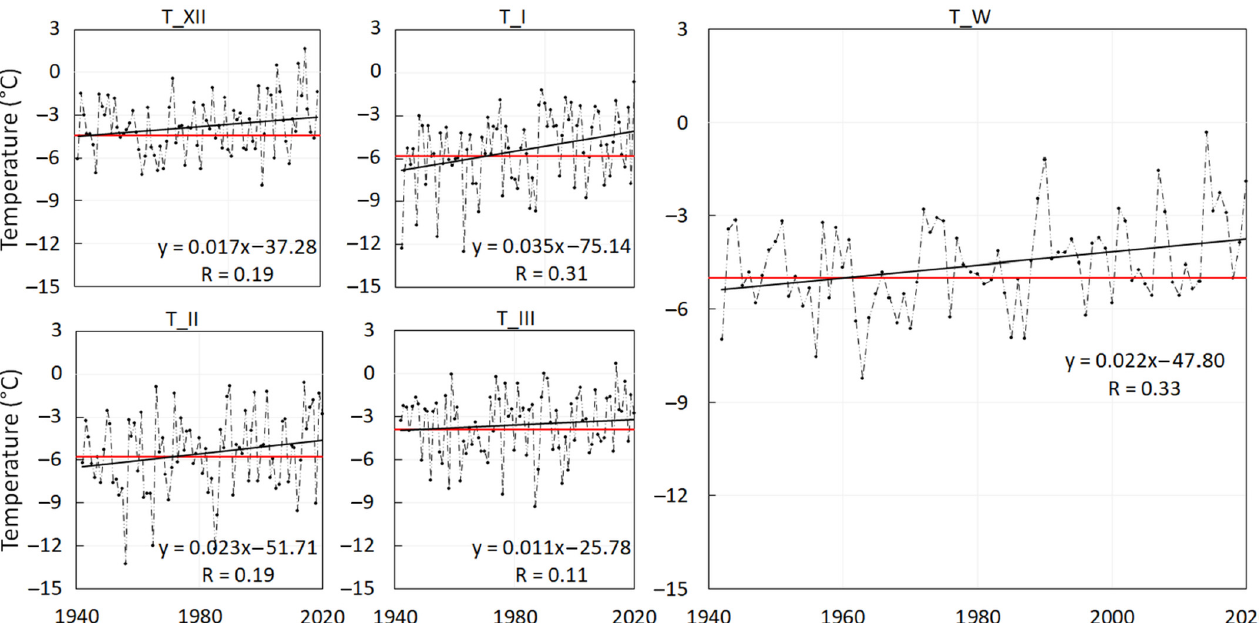
Figure 5. Dashed lines show the average monthly air temperatures of December (T_XII), January (T_I), February (T_II) and